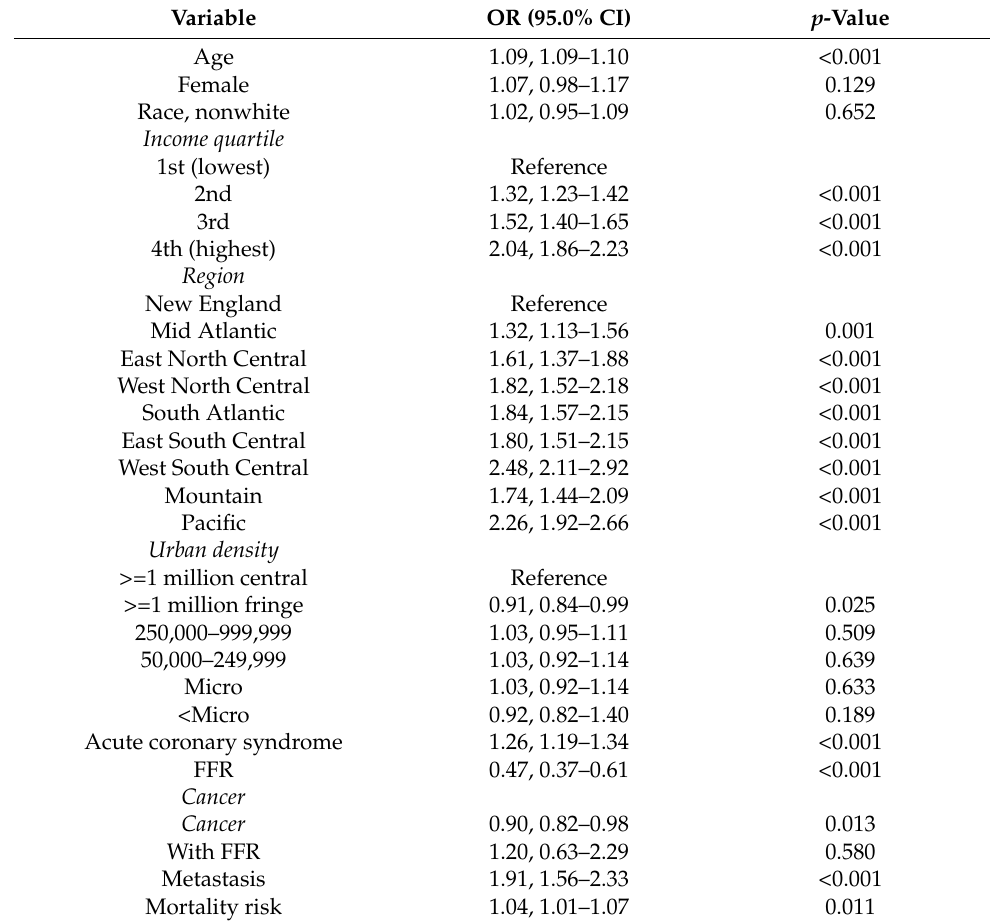
Table 2. Propensity score adjusted machine learning supported multivariable regression of mortality by FFR versus non-FFR PCI.